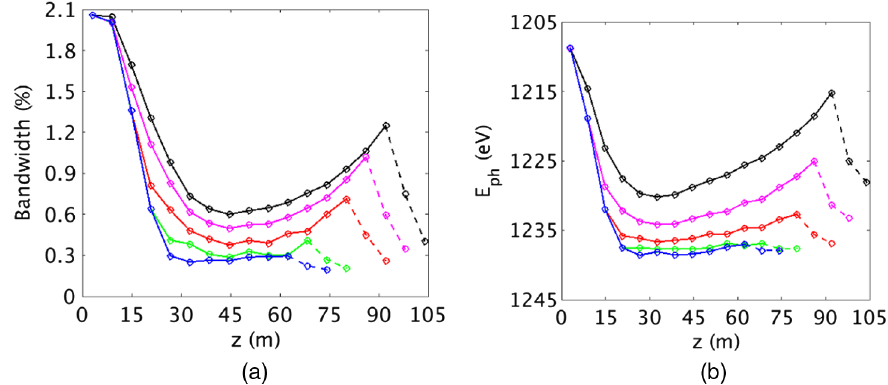
FIG. 7. (a) Bandwidth and (b) the central frequency of radiation along the planar undulator line (solid lines) and the helical undulator line (dashed lines) in simulation results (Fig. 6) using the existing method (black lines) and the modified reverse tapering method with N ¼ 1 (magenta lines), N ¼ 2 (red lines), N ¼ 3 (green lines), and N ¼ 4 (blue lines). z is the propagation distance of the UT UT UT UT electron beam in the undulator